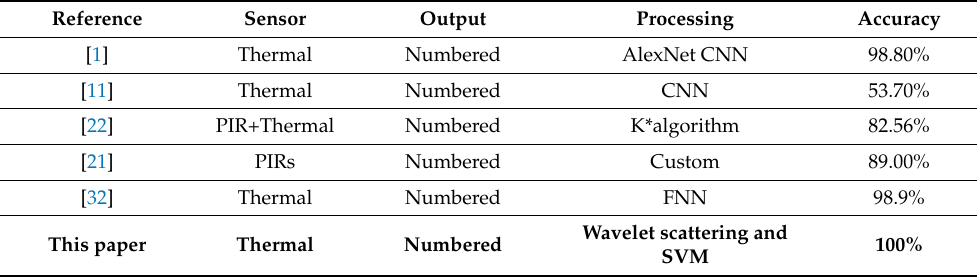
Figure 9. Confusion matrices, accuracy and cross-entropy loss comparison for ResNet-50 and VGG-16 transfer learning frameworks on the validation set. ( a ) ResNet-50 transfer learning architecture, ( b ) VGG-16 transfer learning architecture, ( c ) validation accuracy for ResNet-50 and VGG-16 and ( d ) cross-entropy loss for ResNet-50 and VGG-16. Table 7. Summary of the accuracy of data analysis techniques utilized by other research work.